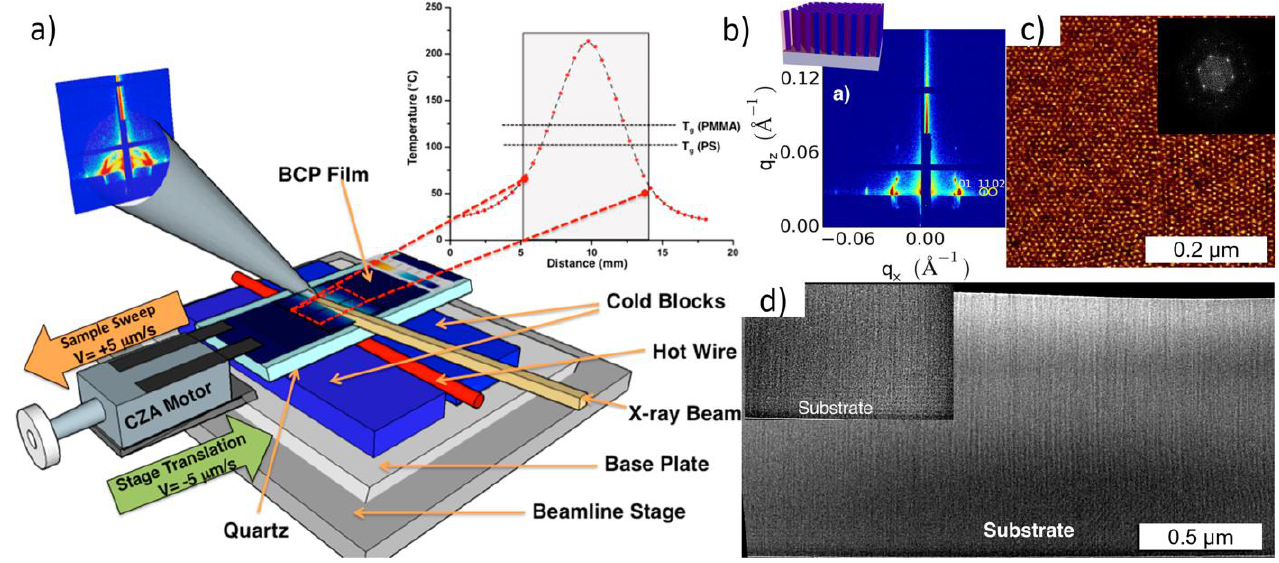
Figure 7. ( a ) Schematic of a cold zone annealing sharp (CZA-S) assembly for in-situ GISAXS ex- periments. ( b ) GISAXS image analogous with a hexagonal lattice with oriented cylinder axes out of the plane. ( c ) Hexagonally packed cylindrical morphology of PS-b-PMMA after CZA-S [102]. ( d ) TEM image of a cross-sectional view of the film with a bimodal orientation Inset: Parallel cylinder orientation near the substrate base [102]. Adapted with permission from reference